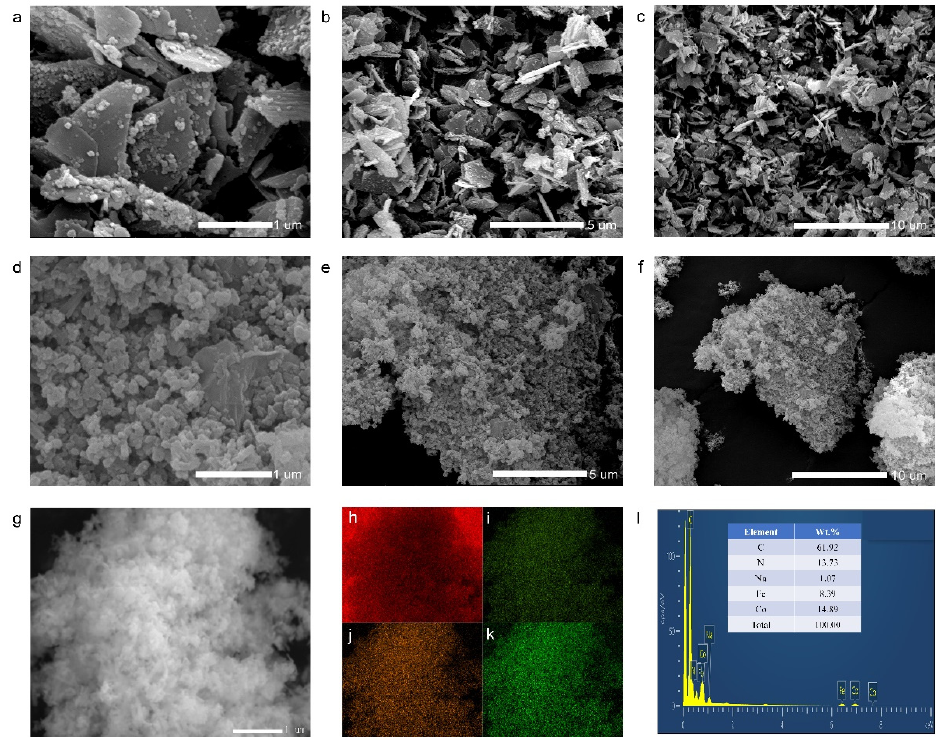
Figure 2. SEM images of ( a – c ) Co-Fe-PBA-300 and ( d – g ) Co-Fe-PBA@rGO; ( h , l ) EDS mapping of Co- Fe-PBA@rGO: ( h ) C, ( i ) Co, ( j ) Fe and ( k ) N and ( l ) EDS spectrum. Co-Fe-PBA@rGO: ( h ) C, ( i ) Co, ( j ) Fe and ( k ) N and ( l ) EDS